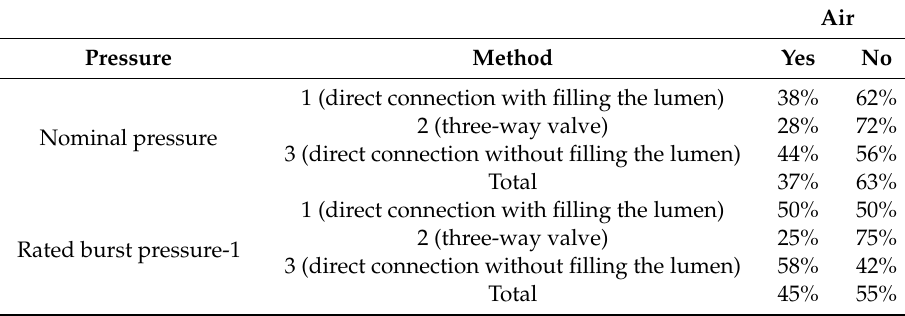
Table 6. Air in the balloons for the di ff erent pressures.